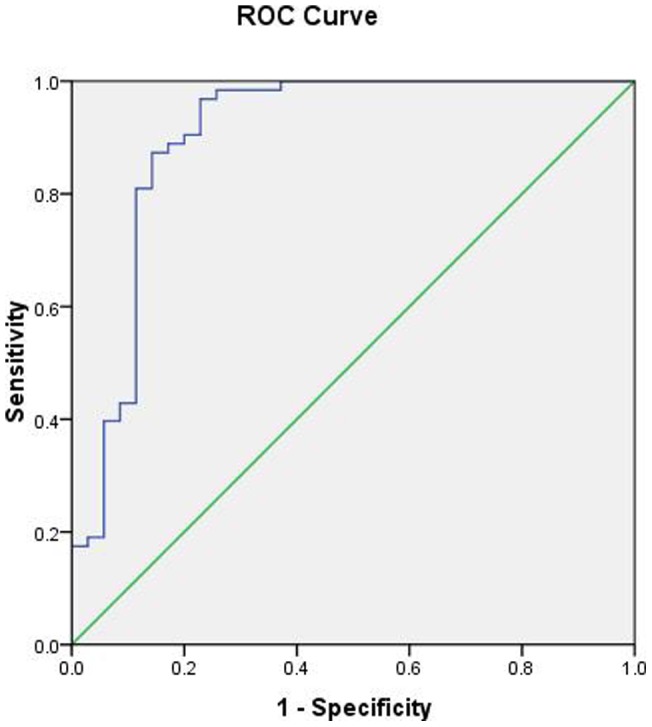
ROC analysis of ceruloplasmin levels at aGvHD diagnosis.(ROC) curve analysis of patients with aGvHD (n = 72) and without aGvHD (n = 26). At a cutoff value of 780 μg/ml, the corresponding sensitivity was 0.905, the specificity was 0.8, the area under the ROC was 0.902 (95% CI 0.825, 0.979; P<0.001), and the standard error was 0.039.